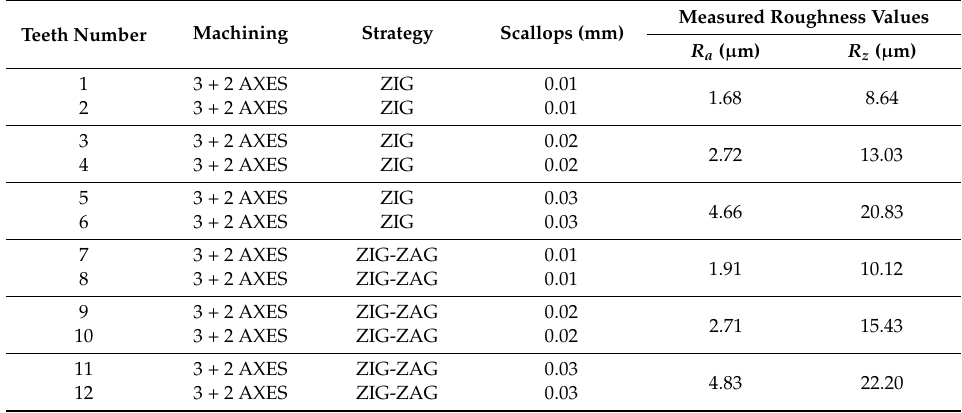
Table 4. Roughness measured results for gear teeth after finishing strategies.